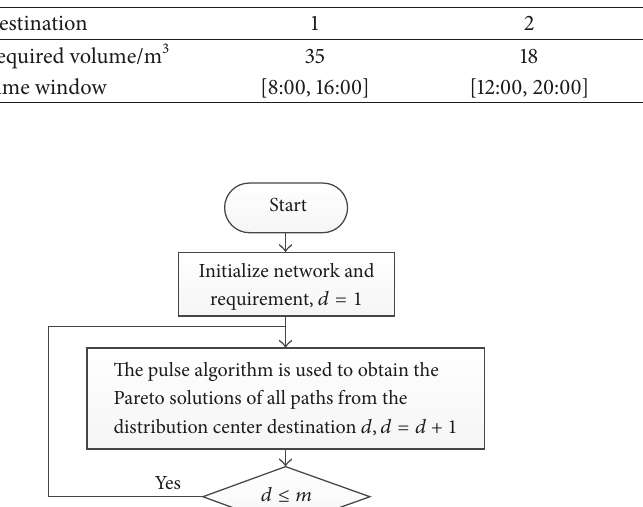
Table 2: Required transport volume and time window of a destination.